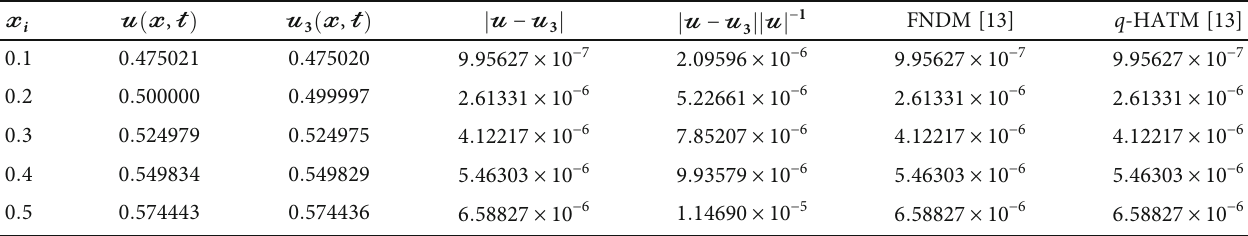
Table 1: Comparison of numerical outcomes for FGEs (21) and (22) with = 0 : 2, α = 1 , and λ = 1 .